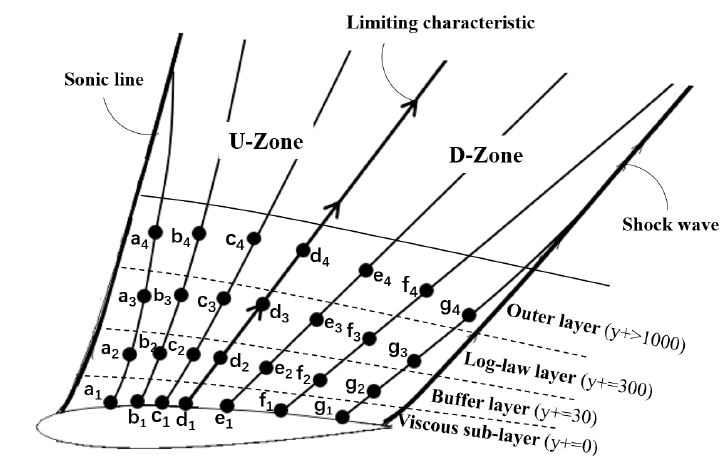
Figure 6. The distribution of measuring